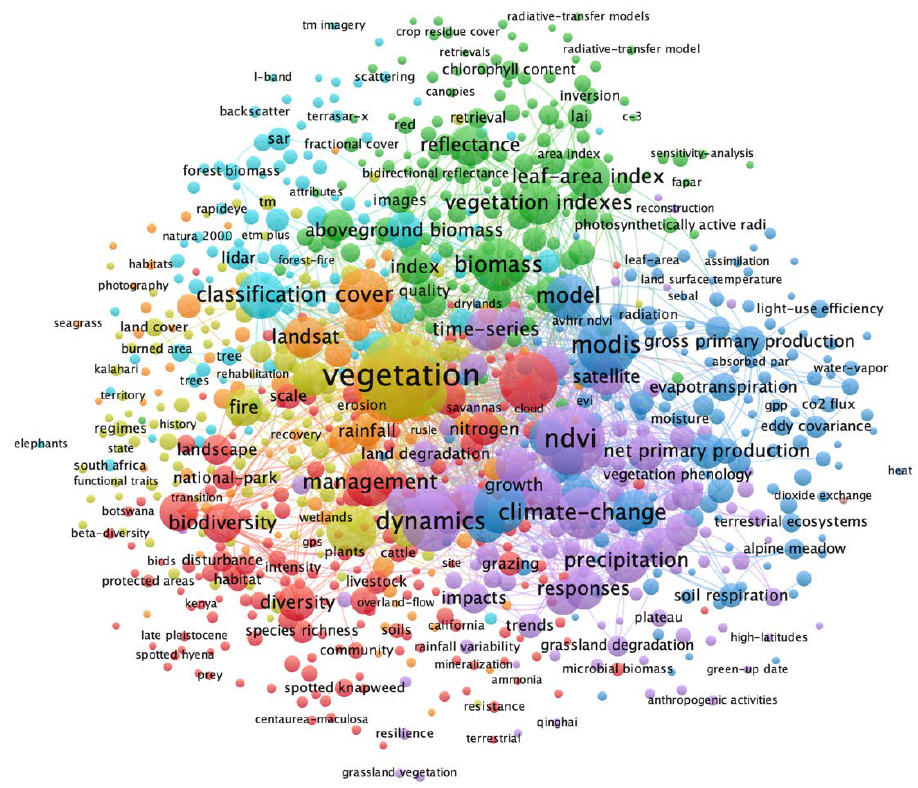
Figure 6. Network of keywords based on the co-occurrence method on GRS research from 1980 to 2020. Table 5. Top 30 keywords on GRS research studies from 1980 to 2020.